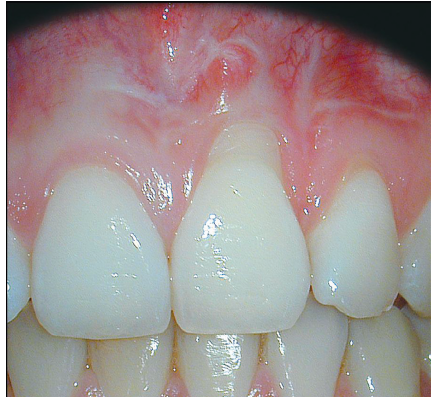
Figure 1: Clinical conditions at baseline. It was noticeable the scar tissue in the region of the intervention and the persistence of a gingival recession of 2.1.